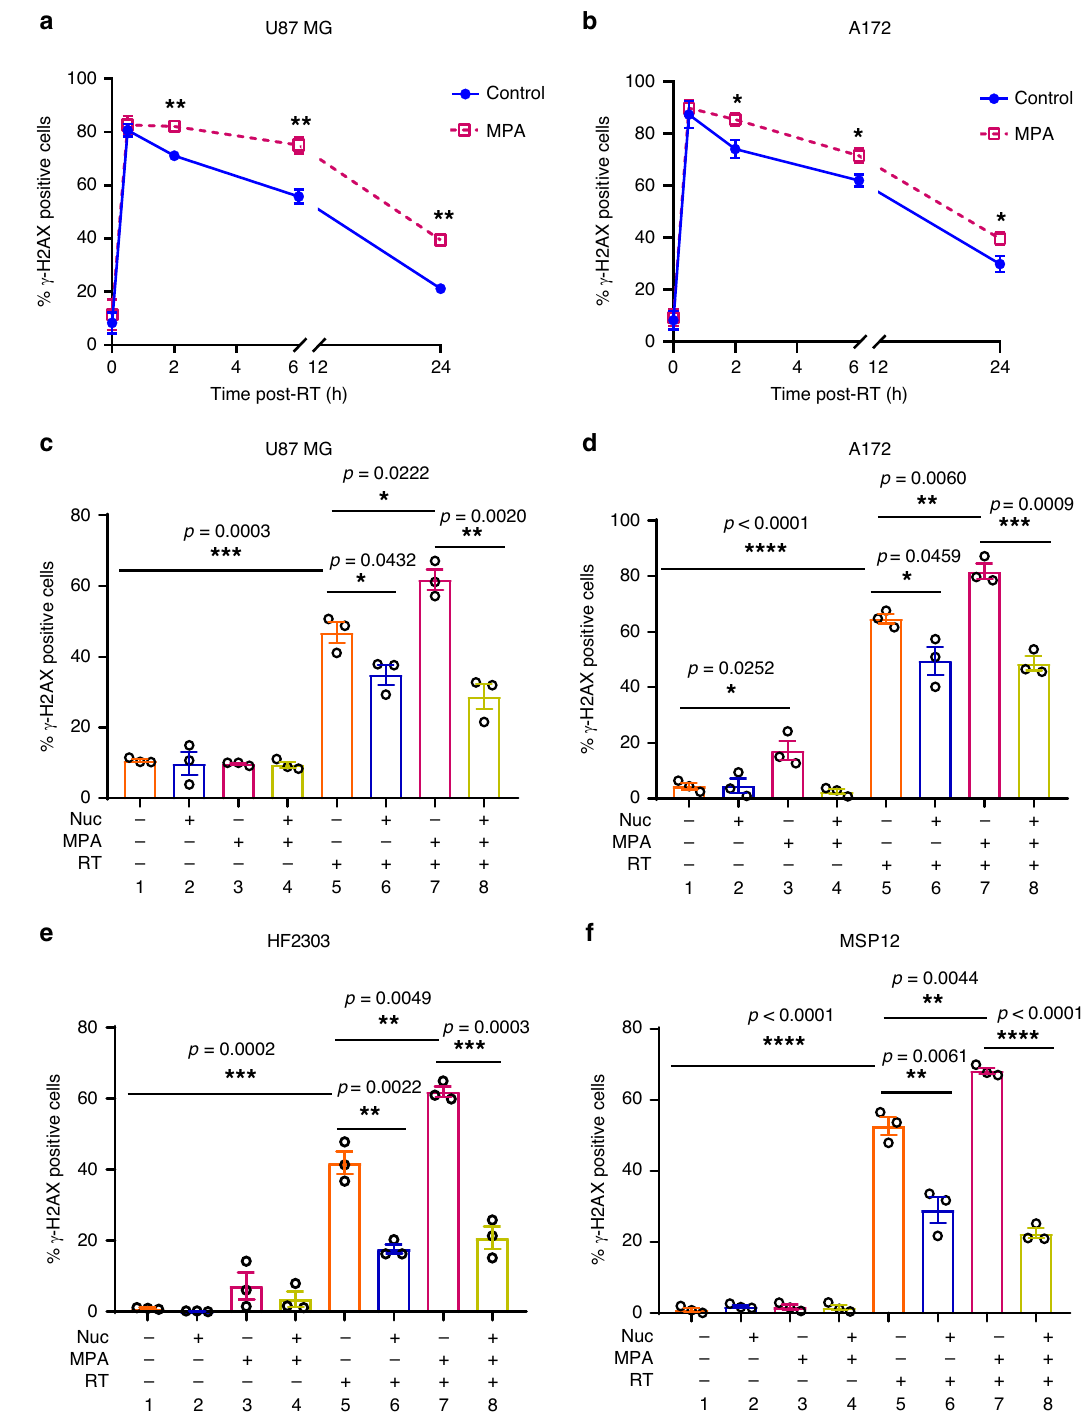
Fig. 4 Inhibiting GTP synthesis impairs DNA repair in a nucleoside-dependent fashion. a – b Cells were treated with 10 µ M MPA for 24 h and